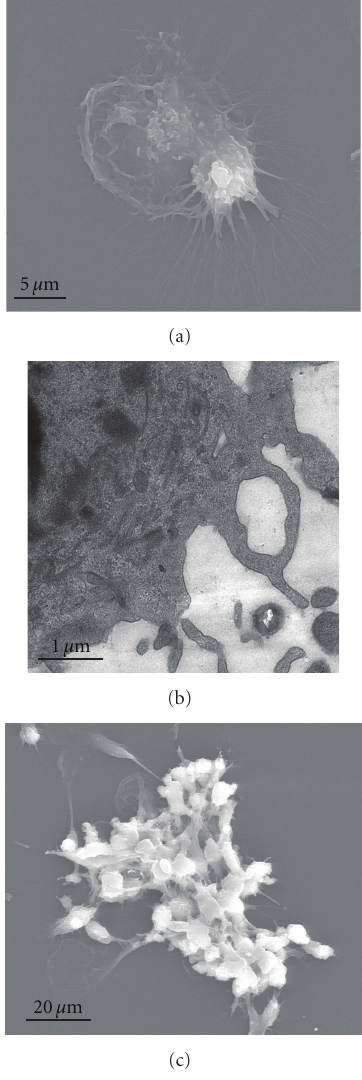
Figure 1: The morphological changes of k-ras pulsed DC and K- ras-DCCIK under scanning and transmission electron microscopy (experiment 2.5). DCs pulsed with K-ras mutant peptide show a larger soma, and plenty of dendritic bulges on their surfaces (Figure 1(a)). Under transmission electron microscopy, DCs show irregular-shape, large, and long dendritic bulges on their surfaces. In the DCs, organelles are abundant, and many mitochondria and rough endoplasmic reticulum can be seen, but less lysosome are present (Figure 1(b)). Coculture of DCs and CIKs for 14 days; un- der scanning electron microscopy, cells aggregated together to form many cell masses, on the surfaces of which there were plenty of dendritic bulges (Figure